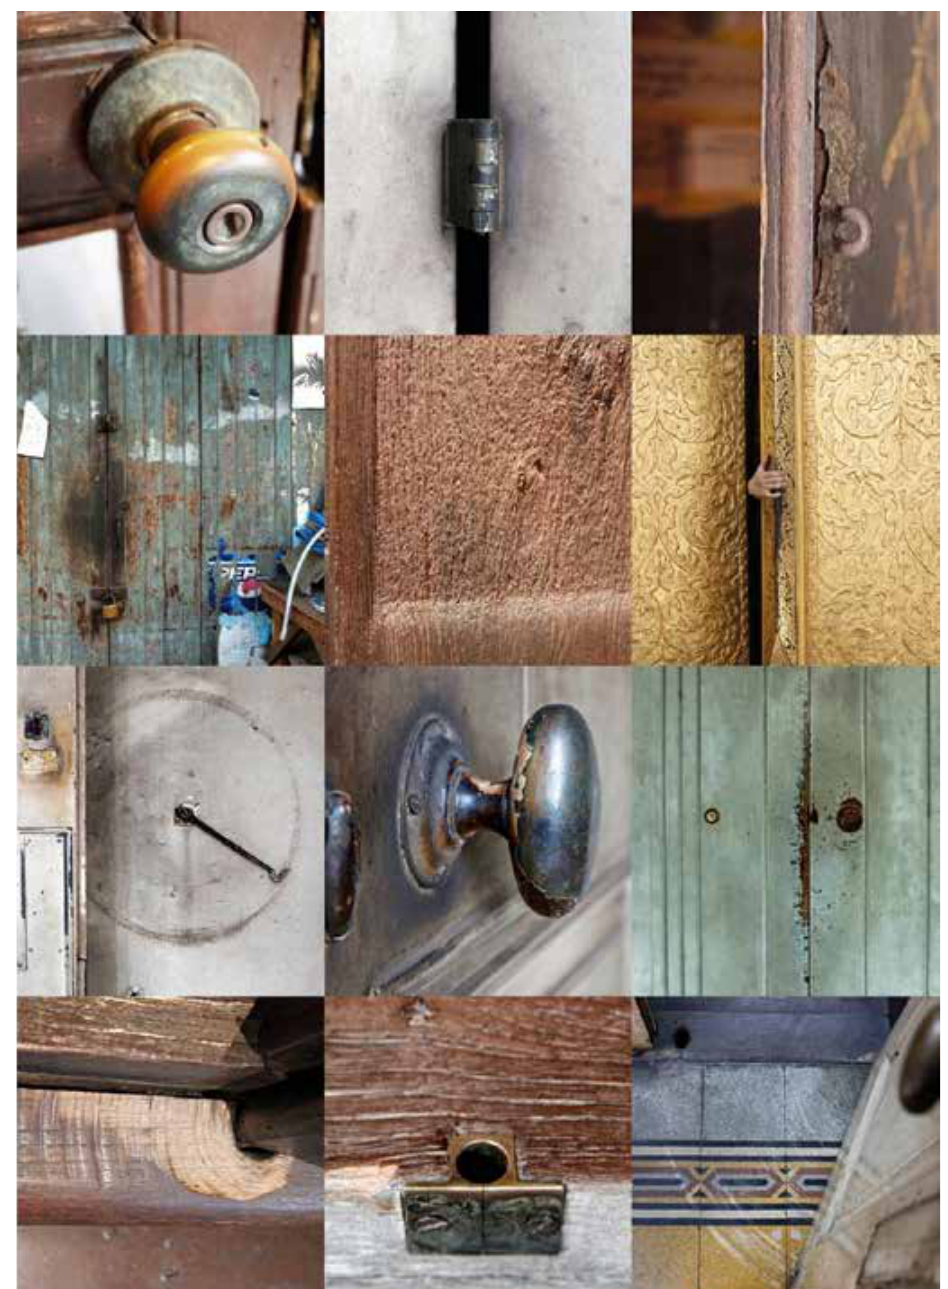
Figure 1: Opening doors and crossing thresholds. Observing old, well-preserved, perfectly neglected architecture, the patterns of wear from both intended and incidental use are conspicuous. The sun, the rains, hands, and movements all leave their marks. Source: